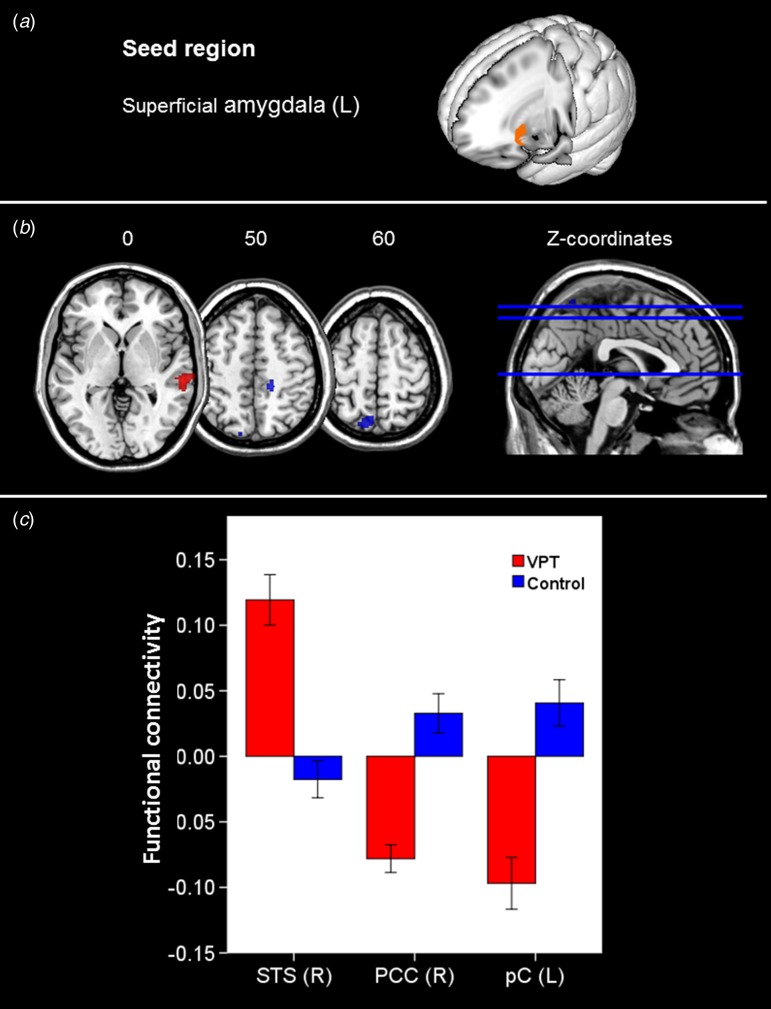
Alterations in functional connectivity of the left superficial amygdala in very
preterm birth (VPT)  individuals compared to controls. (a)
Location of 50% probabilistic masks of the superficial amygdala of the left
hemisphere projected on the MNI template with neurological convention.
(b) Brain areas that showed significantly greater functional
connectivity of the left superficial amygdala in VPT individuals (hot colour
scale) comprised the right superior temporal sulcus (STS); brain areas that showed
significantly smaller functional connectivity of the left superficial amygdala in
VPT individuals (cool colour scale) comprised the right posterior cingulate cortex
(PCC) and the left precuneus (pC). Brain slices are displayed axially according to
neurological convention, with z coordinates in MNI space above each slice. The
figure on the right depicts these slices in blue on a midline, sagittal slice.
Reported clusters survived a height threshold of uncorrected
p < 0.001 and an extent threshold of FDR-corrected
p < 0.05 at the cluster level. (c) Bar
graph showing direct comparison of functional connectivity strength between the
two groups. The y-axis indicates correlation coefficients between the time series
of the seed region (superficial subregion of the left amygdala) and the time
series extracted from the regions displaying significant between-group
differences; the error bars represent 1 standard error.